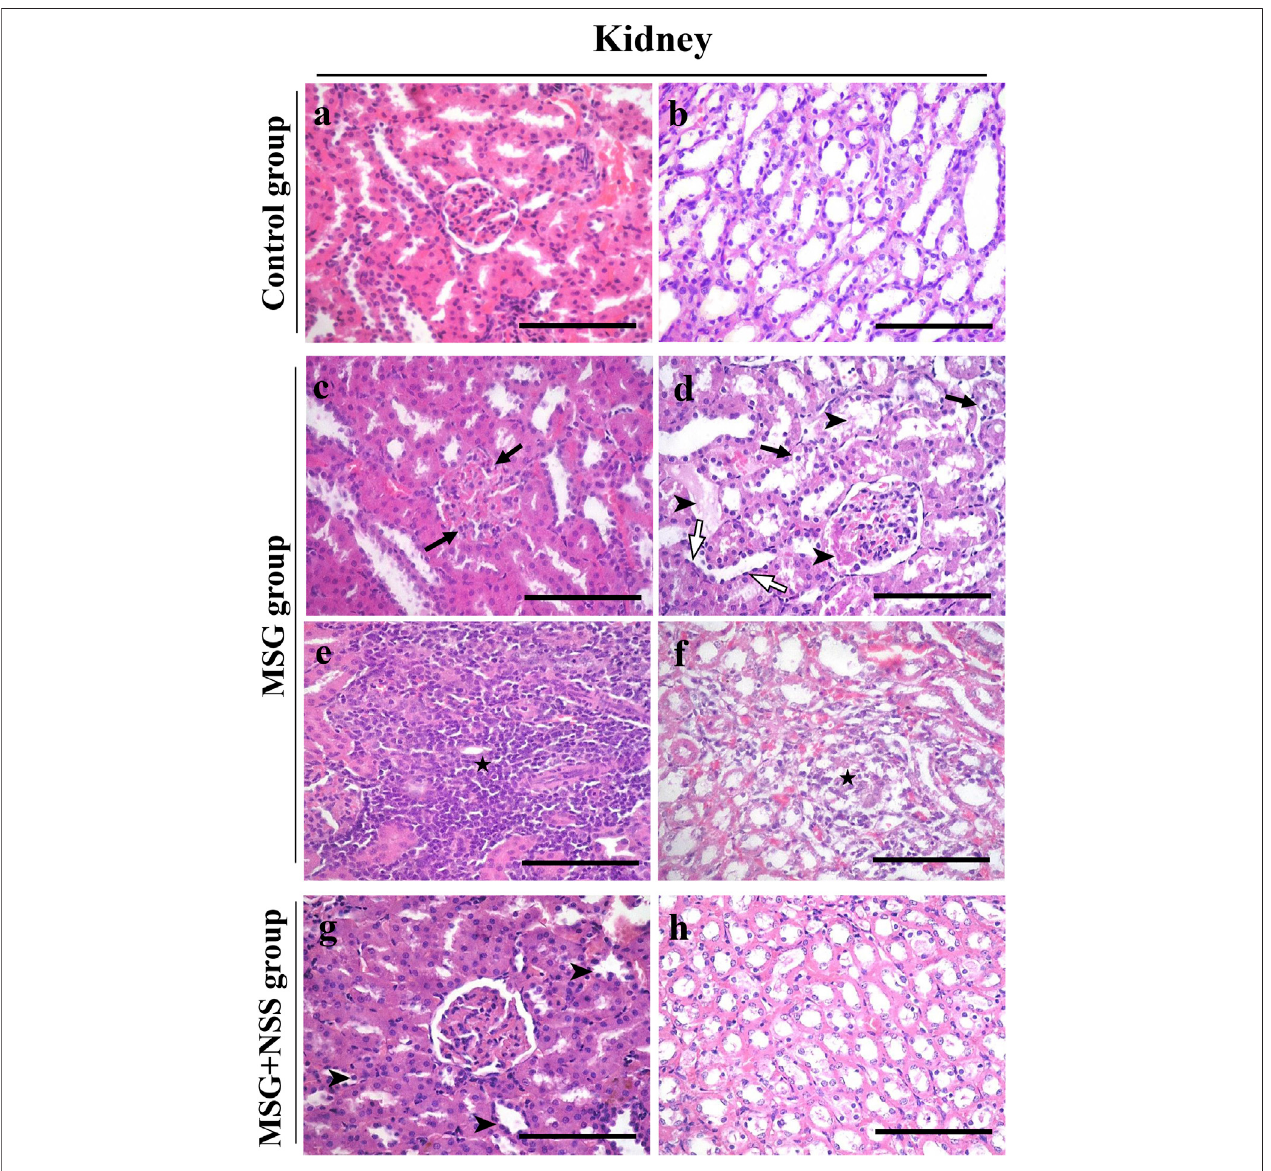
FIGURE1| Histopathologicalchangesofthekidneyincontrol-,monosodiumglutamate(MSG)-,andMSG+ Nigellasativa seed(NSS)-treatedgroups (A,B) Kidney from the control group showed a normal renal cortex, containing normal glomerulus with Bowman ’ s space and the surrounding renal tubules (A) , and renal medulla (B) (C – F) MSG-treated group showed membranoproliferative glomerulonephritis (arrows) (C) leading to hyalin casts in the bowman ’ s space and renal tubular lumens (arrowshead) (D) . The renal tubules showed degeneration and necrosis and vacuolated cytoplasm (arrows) (D) , and fl attened epithelium (white arrows) (D) . Mild congestion and lymphoid cellaggregation intheinterstitium(star) (E) .Themedullaryregionshowednecrosisand lymphoid cellin fi ltration (star) (F)(G,H) Kidneyfrom the MSG + NSS-treated group showed shortening of the tubular epithelium (arrowshead) (G) and minimal necrotic area in the medulla (H) . Hematoxylin and eosin stain. Scale bars = 50 μ